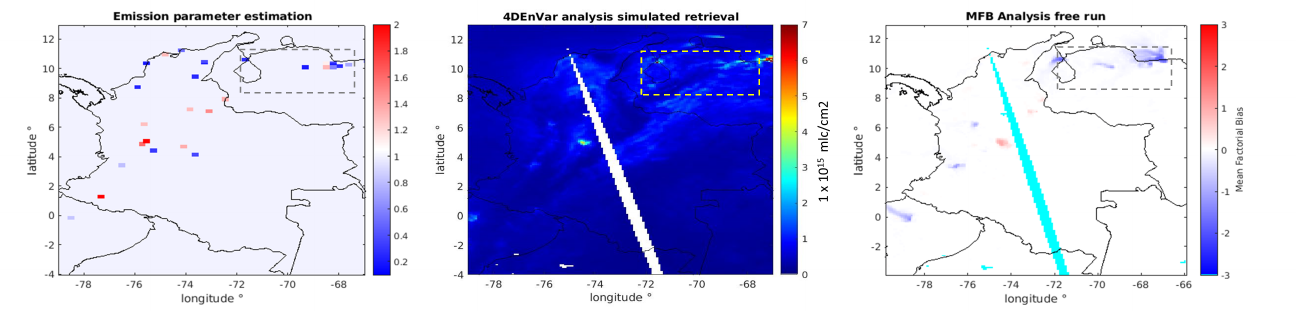
Figure 8. NO 2 emission factor adjustment. ( Left ) Estimates of the emission factor adjustment ( δ e ) over the 27 locations ( Center ), simulated TROPOMI NO 2 columns from the analysis run using the newly-estimated emission factors. ( Right ) Mean Fractional Bias in NO 2 column between LOTOS-EUROS simulations with the adjusted emission factors (analysis), and the simulations with the default emissions factors